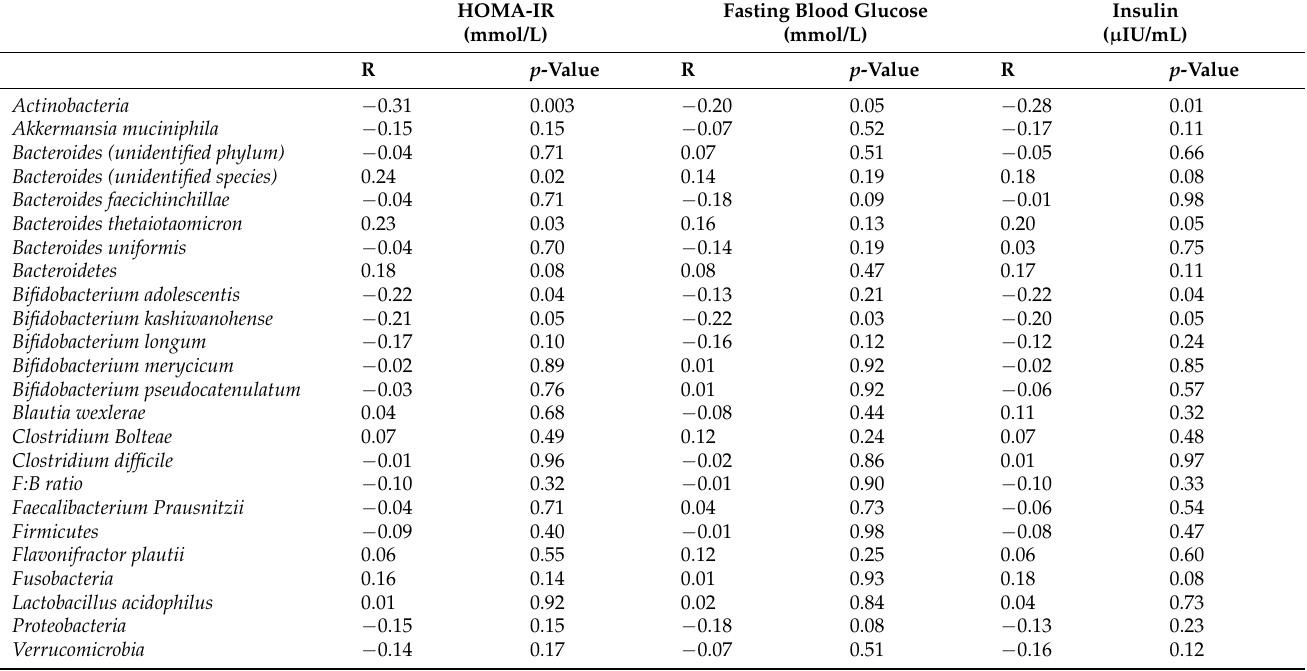
Table 2. Correlation between gut microbiota and glycemic control